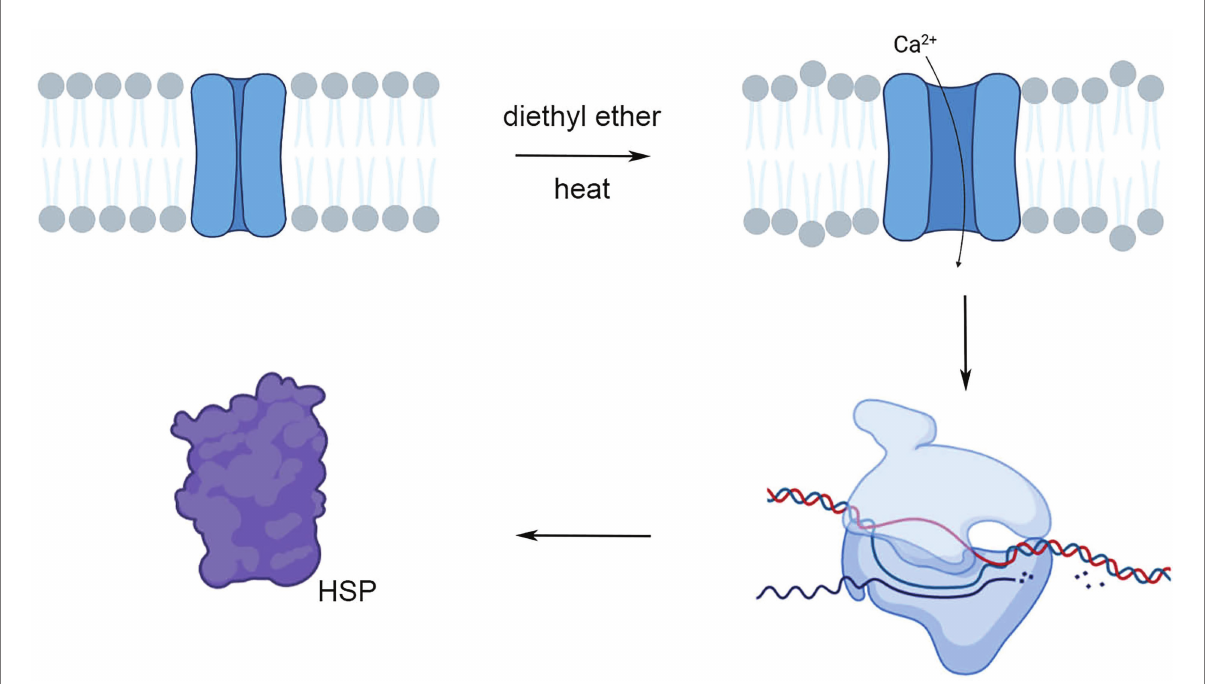
FIGURE 11 The hypothesis about similar action of diethyl ether anesthesia and heat stress on HSP expression. Both, anesthesia and heat stress fluidizes a membrane and affect Ca 2+ channel function. The consequent Ca 2+ entry into the cytoplasm triggers signaling cascade leading to the changes of gene expression (e.g., induction of HSPs). Created in